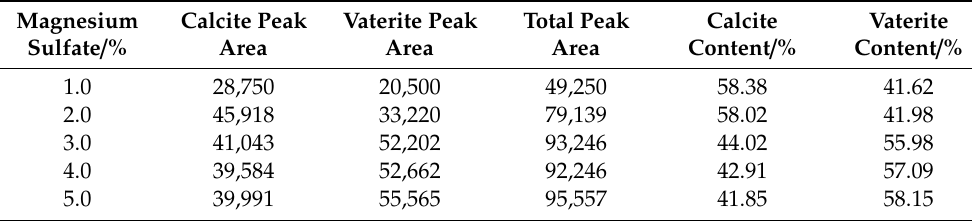
Table 1. The relationship between the content of the di ff erent crystal forms of calcium carbonate and the amount of magnesium sulfate in the magnetized anti-scaling samples.